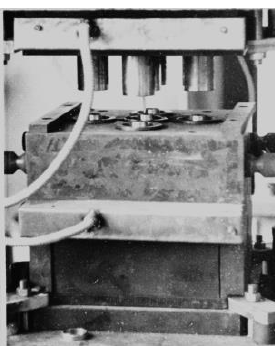
Fig.10. Five-seat mold for the restoration of plain